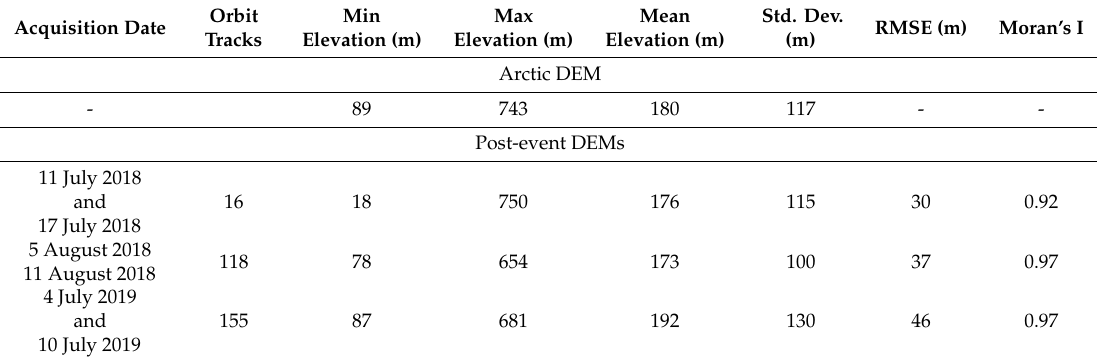
Table 4. Validation of the Sentinel-1 DEMs with respect to the ArcticDEM. Comparison is based on the area not influenced by the landslide. The Moran’s I statistic is calculated on the di ff erence